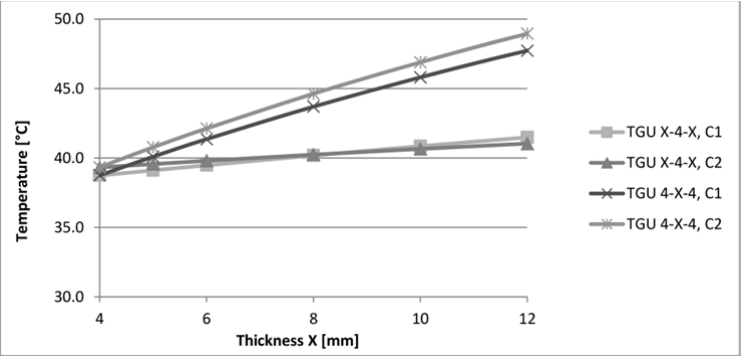
Fig. 5 Influence of Glass-Thickness to Temperature of Cavity’s on